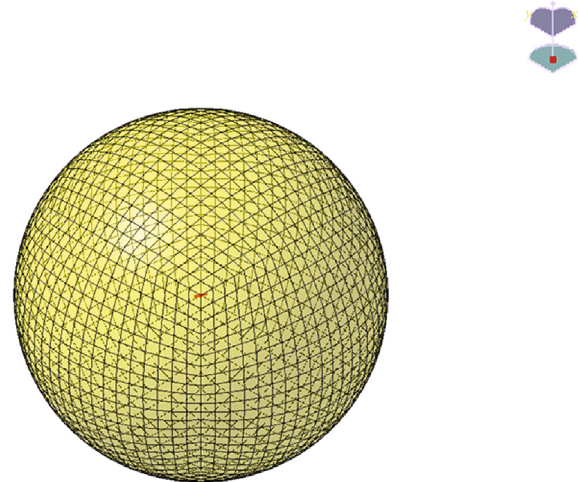
Figure 4: Spherical acoustic radiation model.